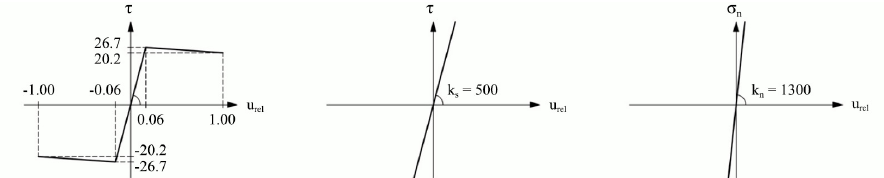
Figure 10: Idealized material-law of the applied epoxy adhesive according to [14] (left); modelled linear elastic shear stress-relative displacement (middle) and normal stress-relative displacement behaviour